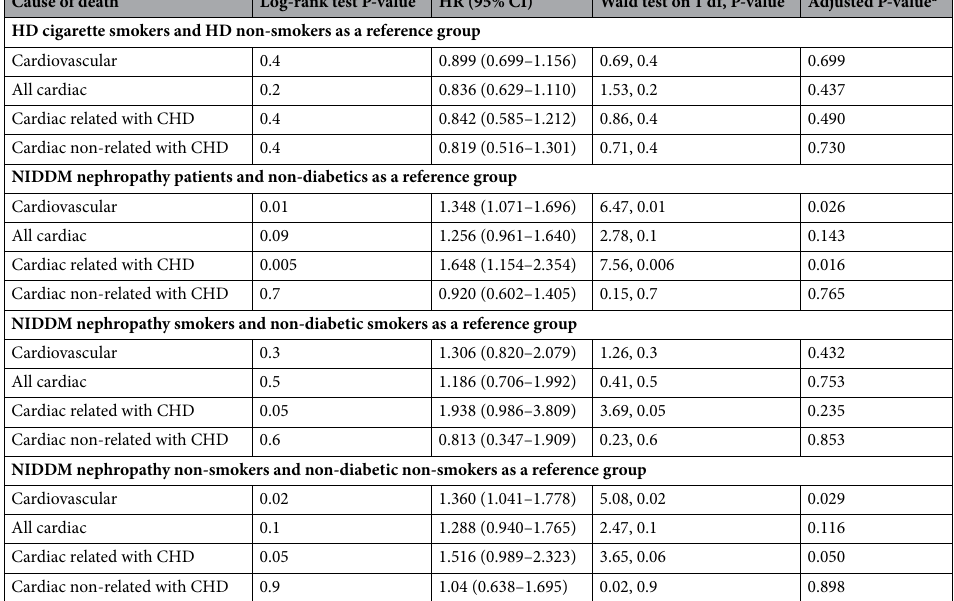
Table 2. Cardiovascular mortality in HD patients categorized by cigarette smoking status and occurrence of NIDDM nephropathy. a Adjustment for age, gender, and HDL-cholesterol.